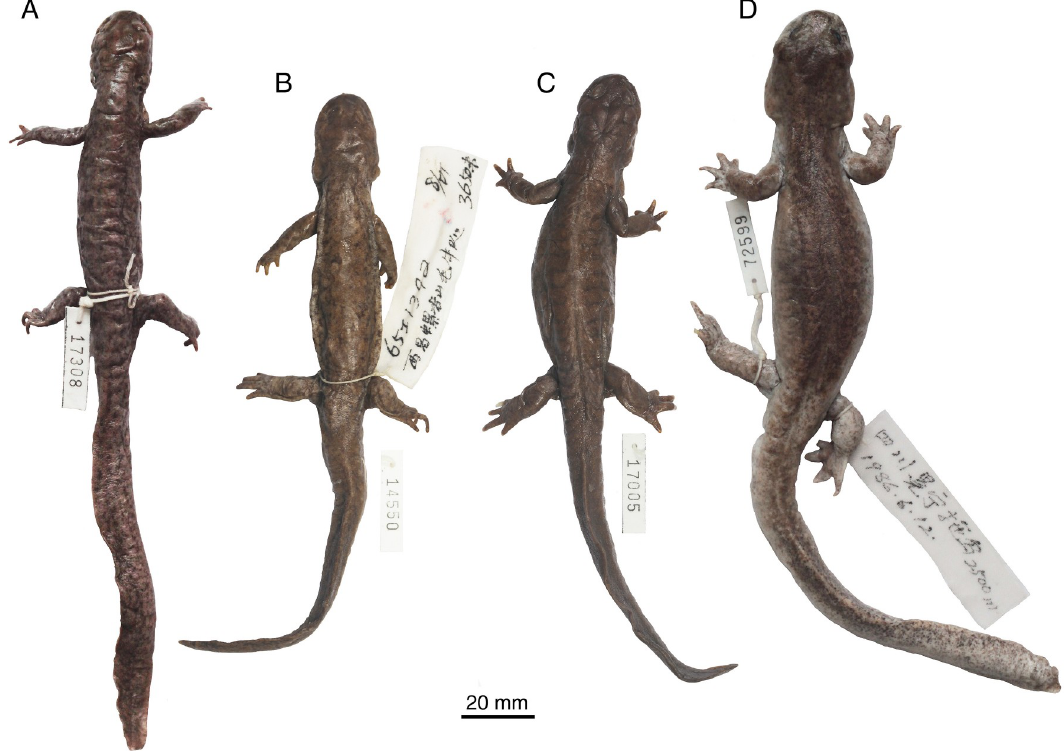
Fig 2. Photographs of representative formaldehyde-preserved specimens of Batrachuperus yenyuanensis in dorsal view. A, CIB 14308 from the type locality Shuangertang, Yanyuan County; B, CIB 14550 from Maoniudui, Dechang County; C, CIB 17005 from Shenguozhuang, Yuexi County; D, CIB 72599 from Tuowu, Mianning